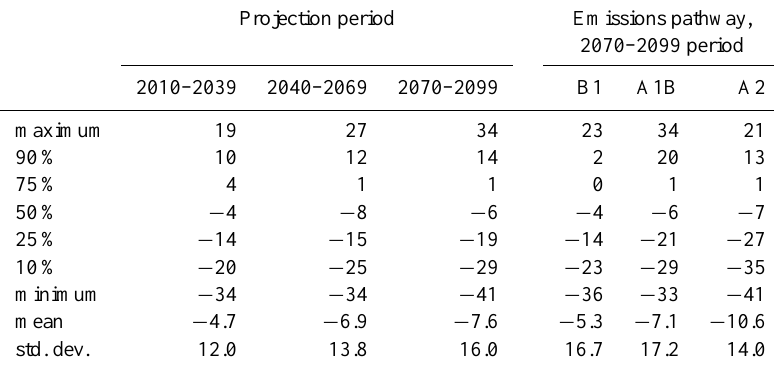
Table 3. Average projected percent change in streamflow for 30-yr periods ending in 2039, 2069 and 2099, and for different SRES emissions pathways for the latter period, calculated for different percentiles and statistics of the ensemble distribution. Positive values are flow increases, in